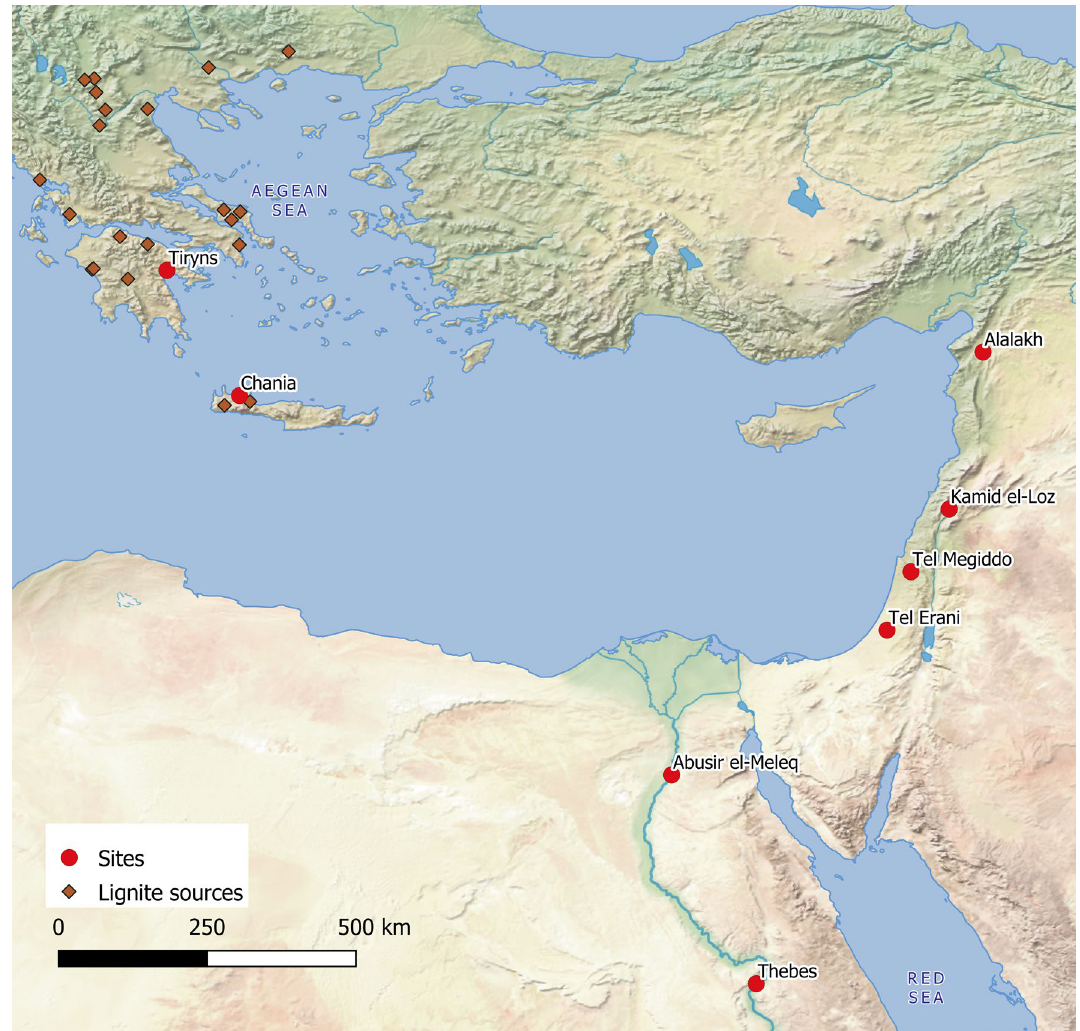
Figure 1. Map of the Eastern Mediterranean featuring the sites included in this study and the currently-known key lignite sources in Greece (created by R.C.P. with QGIS3, using Natural Earth raster data: QGIS.org, 2021. QGIS Geographic Information System. QGIS Association. http:// www. qgis.